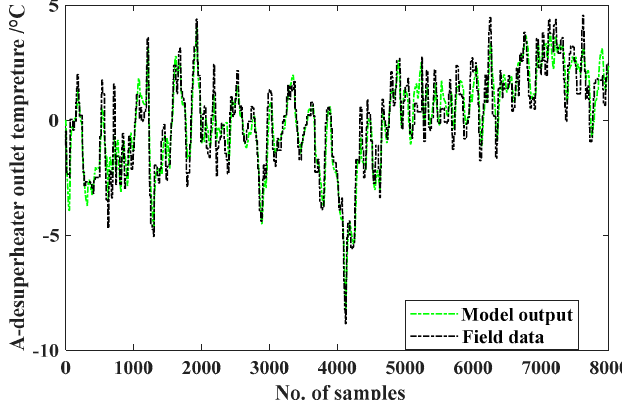
Figure 6. Output fitting of A-lead sector model.